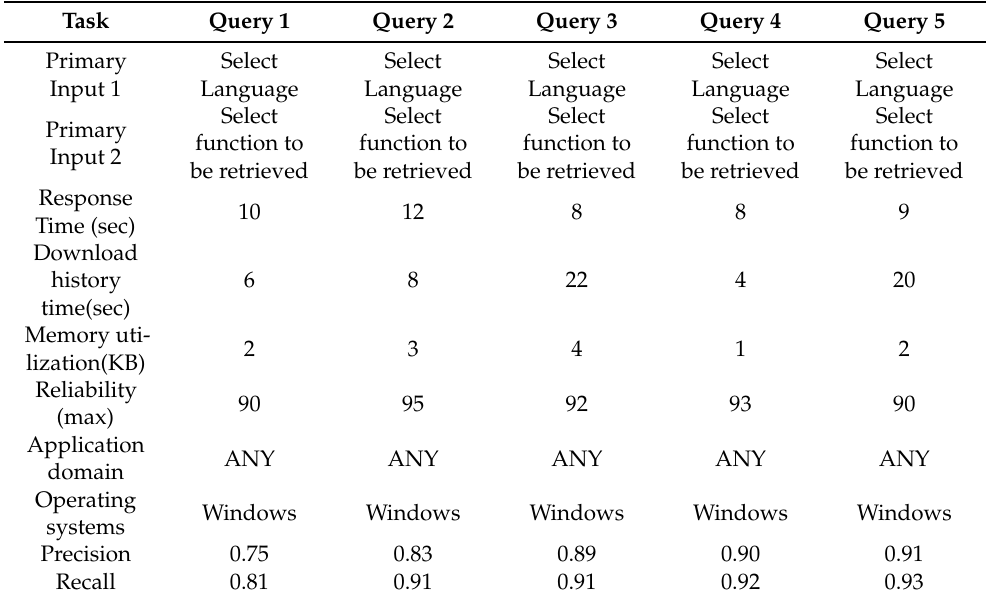
Table 4. Candidates’ component evaluations.